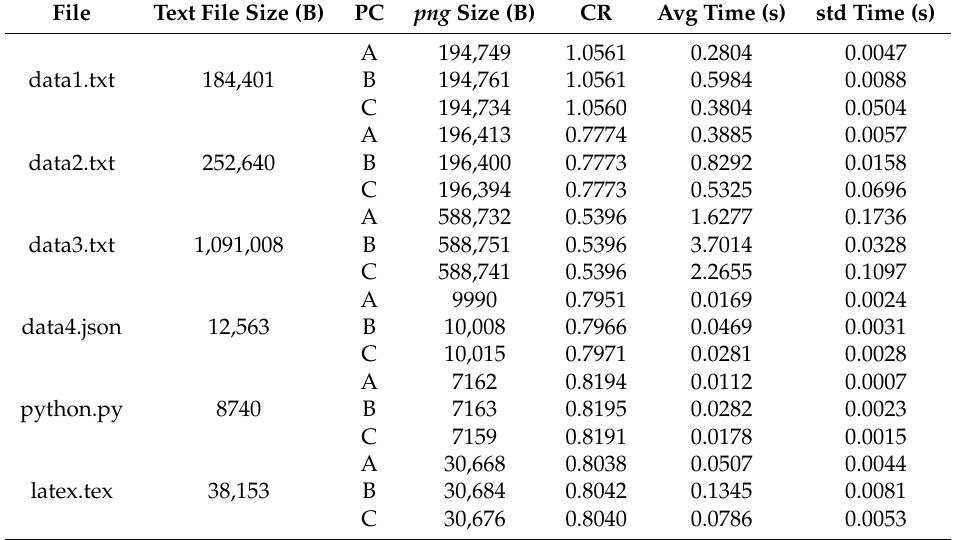
Table 2. Results for selected test files using variant 2 of the method (UTF-8 coding). The list of columns includes filename, size of the text file, PC specification identifier, size of the png file, CR, average time needed to create the png file and standard deviation of the time. The script has been run 100